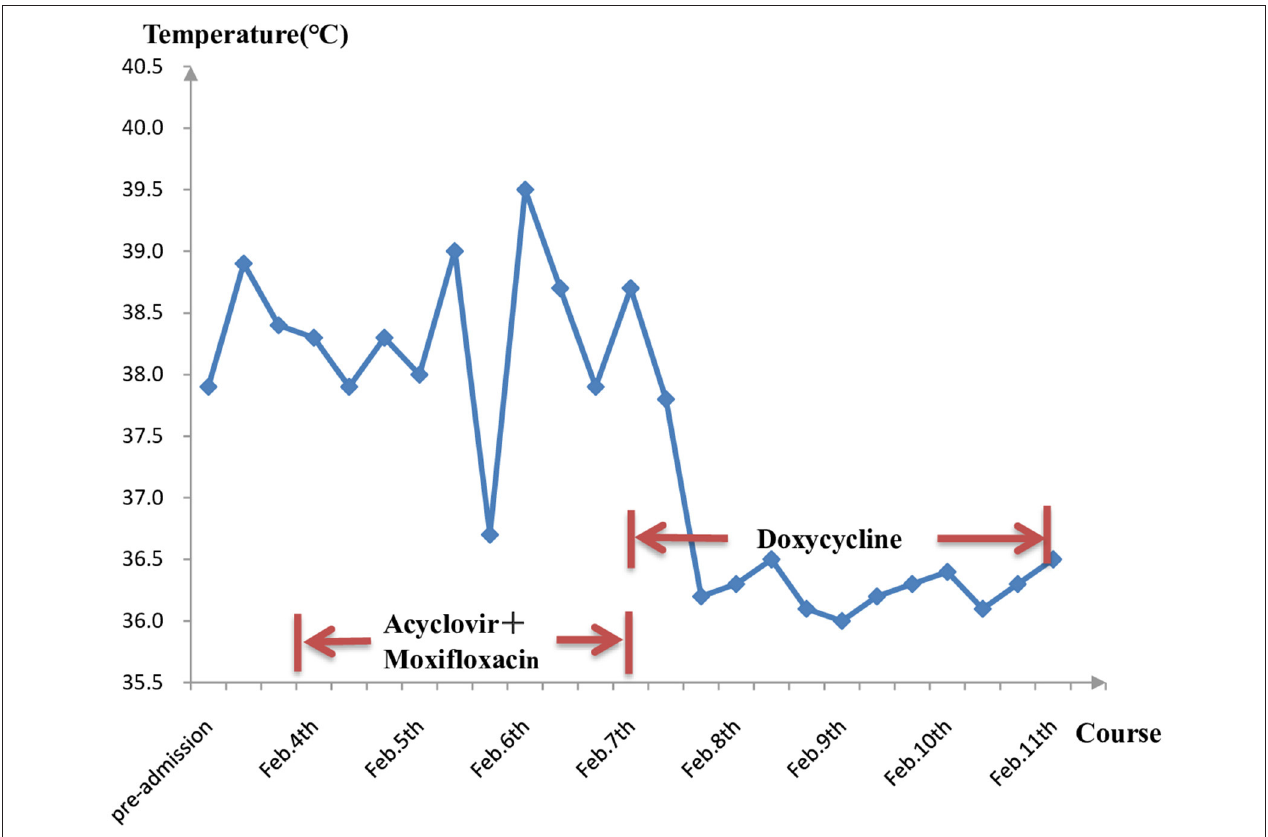
FIGURE 3 | Longitudinal analysis of temperature and medication. After using specific drugs—doxycycline, the temperature was under control and didn’t bounce back